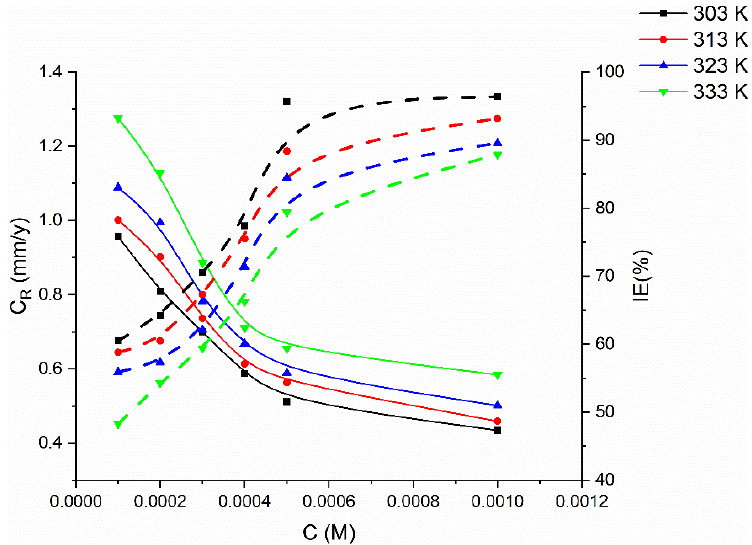
Figure 3. Gravimetric-curve relationship of metal coupons in 1 M HCl between corrosion rate and inhibition efficiency against concentration of PMBMH at different temperatures for 5 h exposure period.